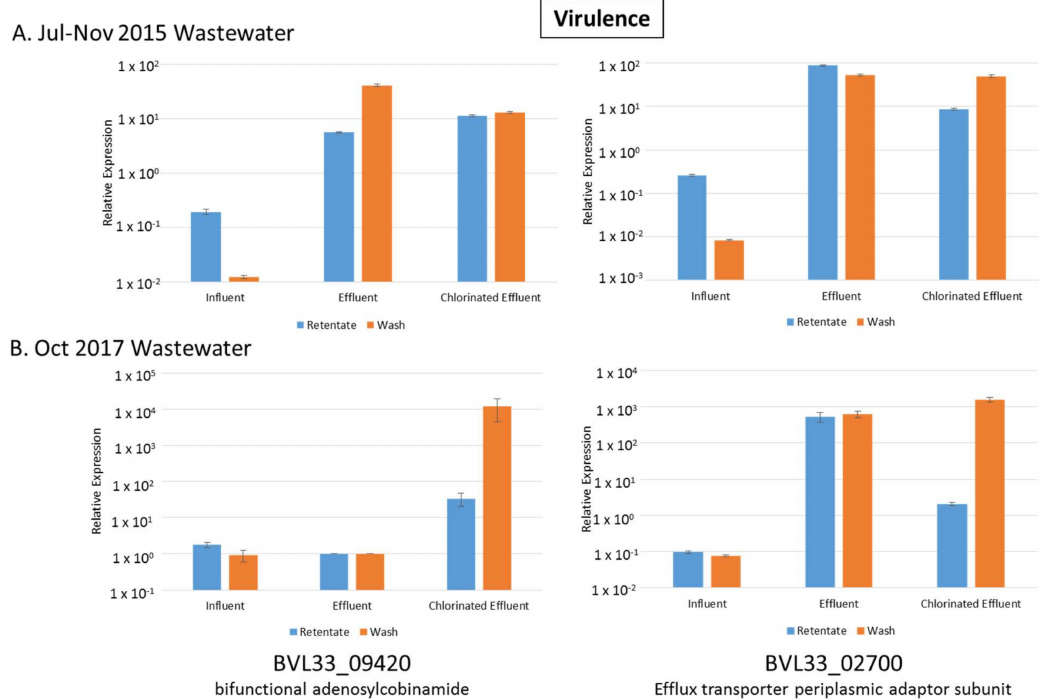
Figure 5. Relative expression profiles of A. junii genes involved in virulence. These genes displayed >2-fold change on RNA-seq analysis of wastewater sampled in July–November 2015 (Table 1). Gene expression values were normalized against a housekeeping rpoB gene. ( A ) Wastewater sampled in July, October and November of 2015; and ( B ) wastewater sampled in October